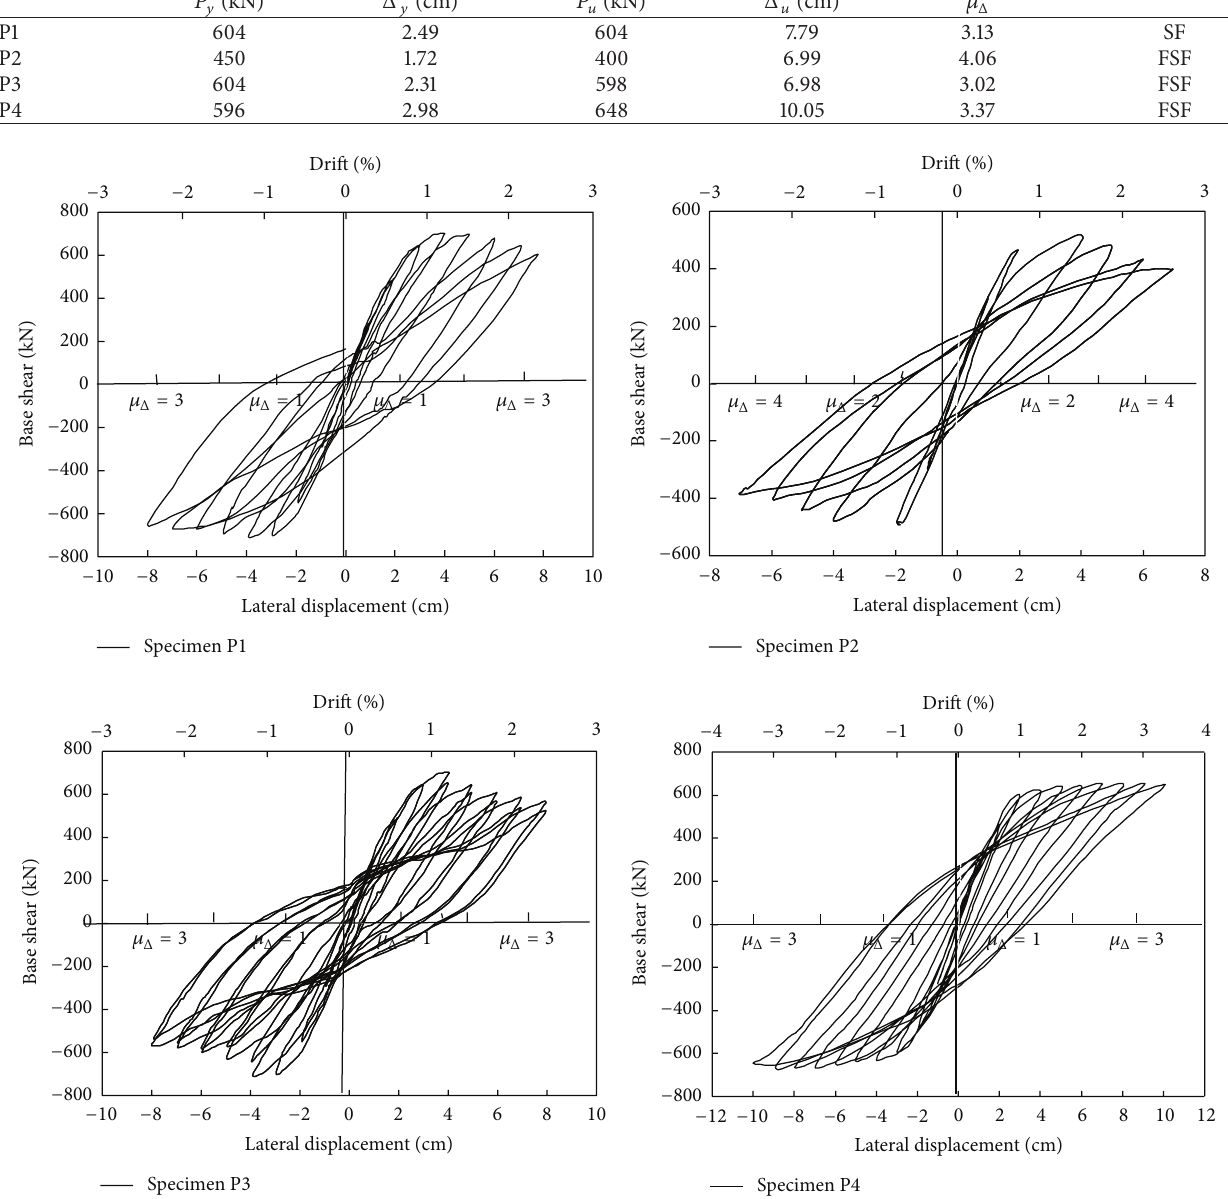
Figure 4: Force-displacement relationships observed in static cyclic